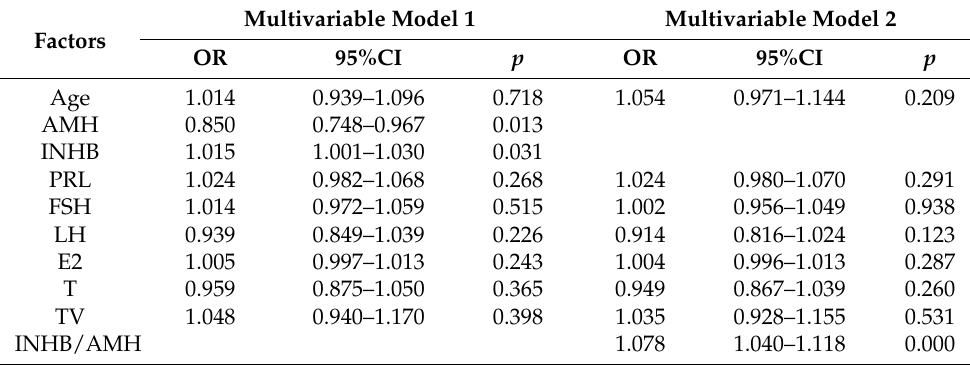
Table 3. Logistic regression analyses for positive sperm retrieval at